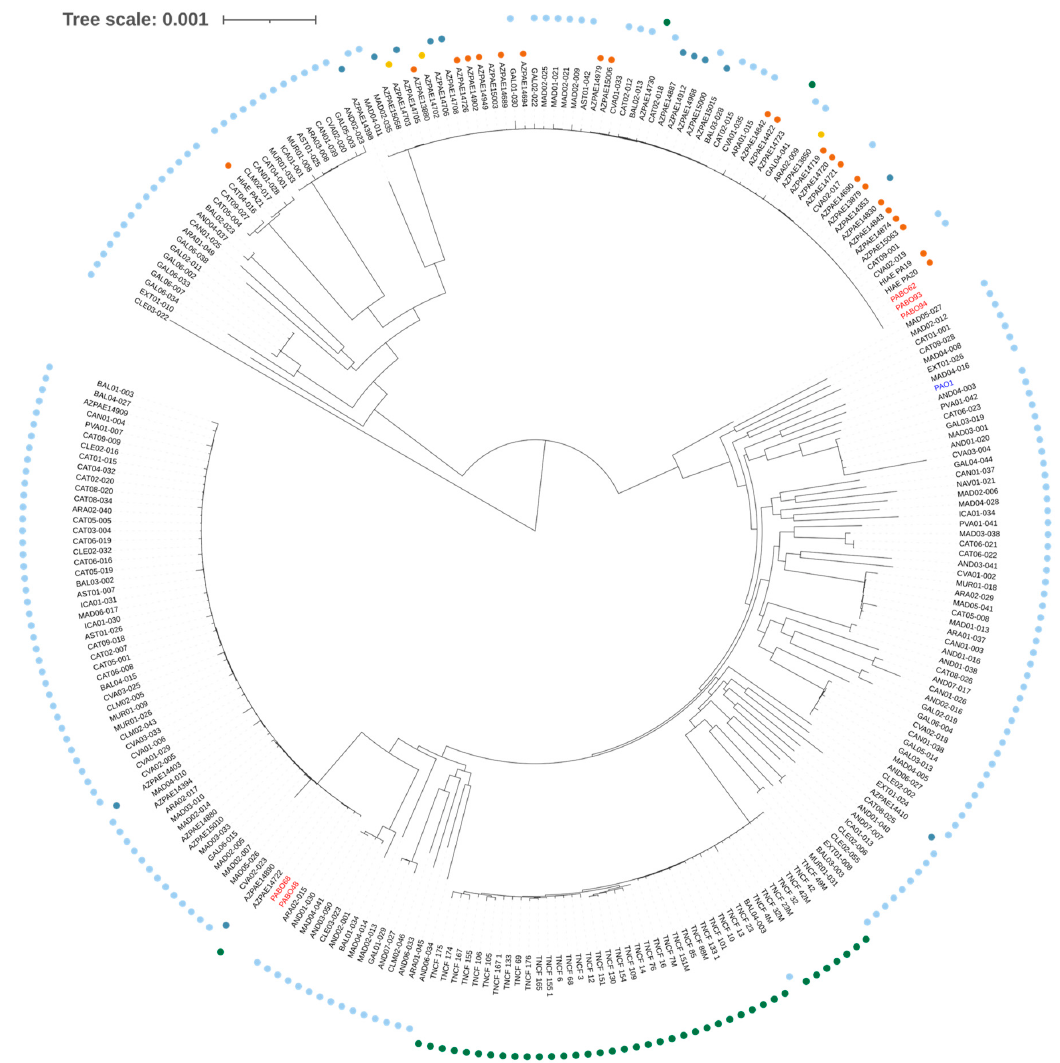
Figure 4. Maximum likelihood phylogeny based on the core genome SNP of the Pseudomonas aeruginosa genomes. The P. aeruginosa strains (clinical and environmental isolates) included in this study are written in red font, and the references strain is written in blue font. Yellow circles indicate strains isolated in Asia, orange circles indicate strains isolated from North and South America, light blue circles indicate strains isolated from Spain, green circles indicate strains isolated from Italy, and dark blue circles indicate strains isolated from other European Union countries.